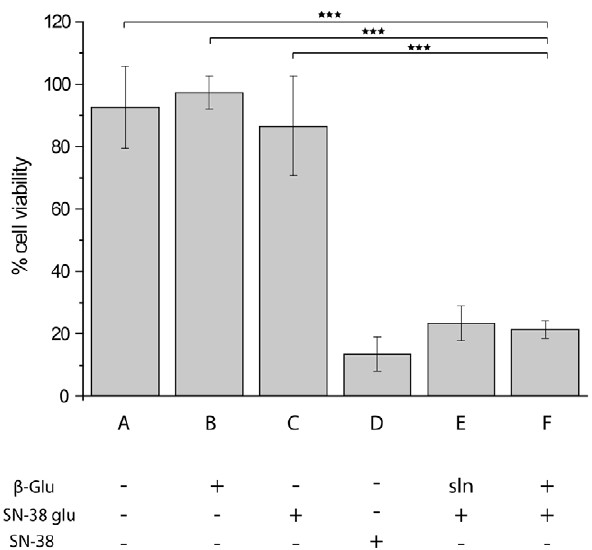
Figure 7. Viability of HepG2 cells cultured on m S PVA thin films as quantified using Presto Blue viability assay and expressed relative to viability of these cells on tissue culture polystyrene at a matched initial cell seeding density. The cells were cultured on (A) pristine m S PVA hydrogels; (B) m S PVA thin films equipped with b - Glu; (C) enzyme-free m S PVA hydrogels in the presence of 1 m M SN-38 glucuronide; (D) enzyme-free m S PVA hydrogels, 1 m M SN-38; (E) m S PVA hydrogels in the presence of 1 m M SN-38 glucuronide and b -Glu added to the cell media (solution based enzyme prodrug therapy); (F) SMEPT conditions, i.e. b -Glu equipped m S PVA thin films in the presence of 1 m M SN-38 glucuronide. Presented results (mean 6 st.dev.) are average over at least 3 independent experiments, 3 replicates each.